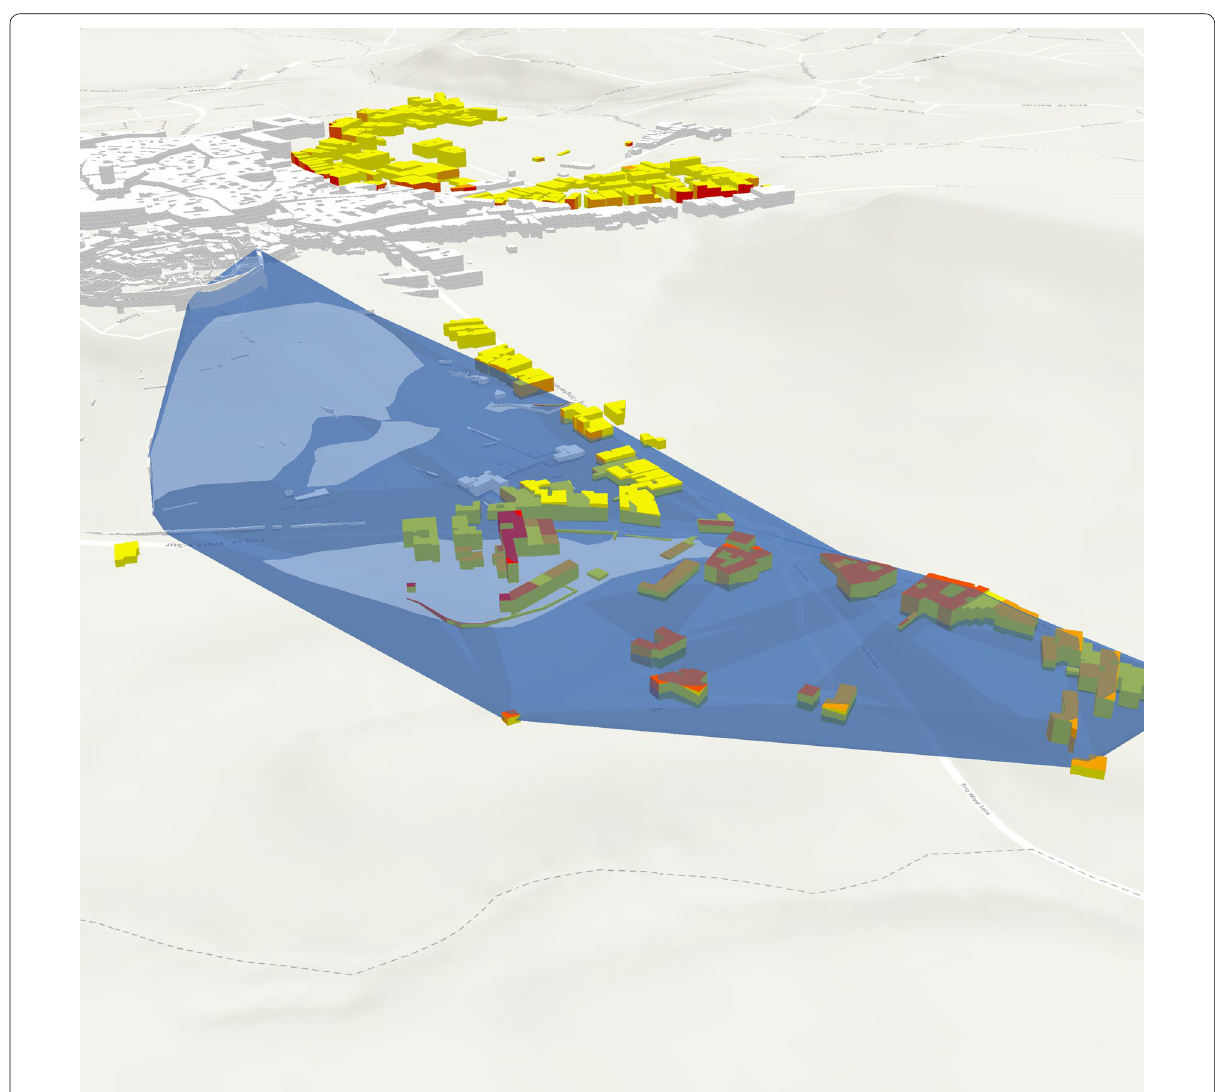
Fig. 16 Visibility analysis carried out on the proposed future state of the built-up northern area of